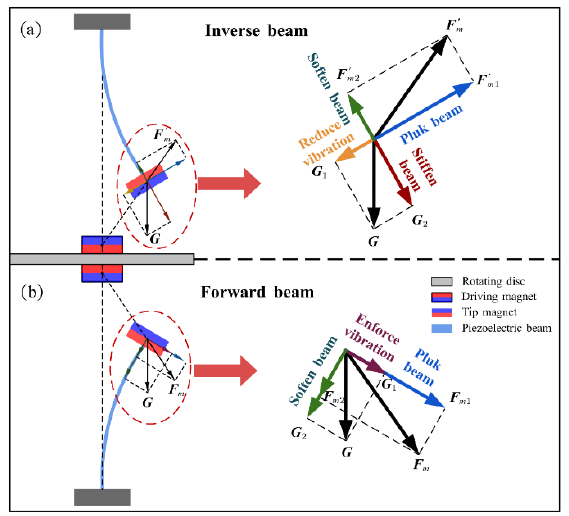
Figure 9. The experimental results of the RMS voltage comparison between the inverse beam (blue line) and forward beam (red line) at 10 mm magnet spacing.